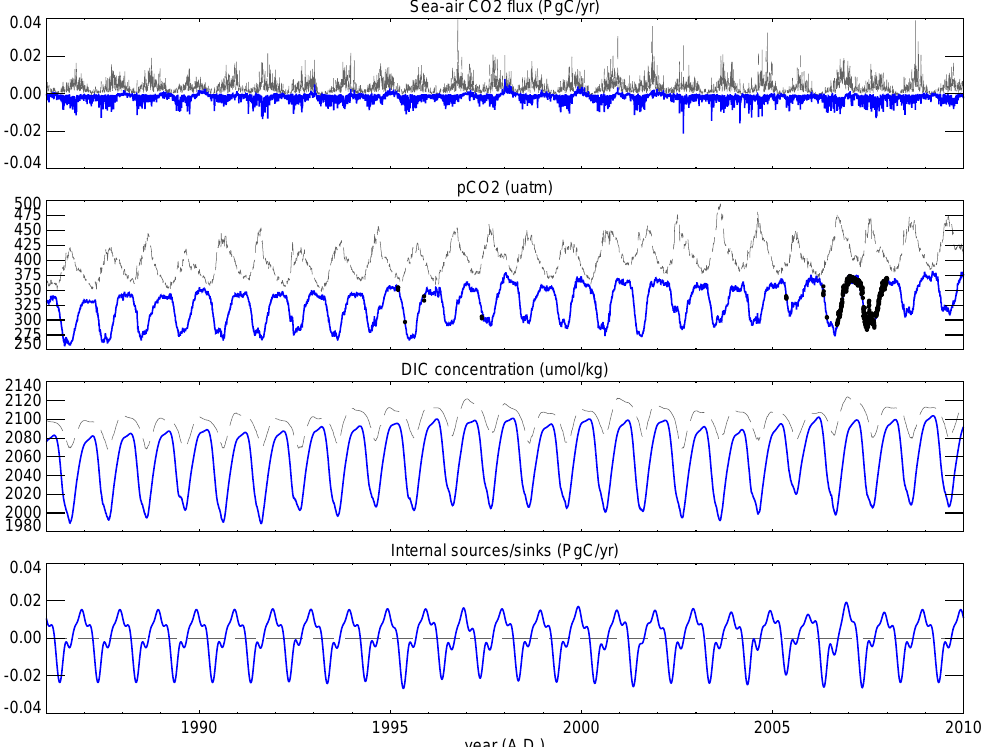
Fig. 3. Example time series (full daily resolution) at the model pixel at around Station M (66 ◦ N, 2 ◦ E) of the main quantities of the diagnostic model (Figure 1): Sea-air CO 2 fluxes ( f CO 2 ma ), surface-ocean CO 2 partial pressure ( p CO 2 m ), mixed-layer DIC concentration ( C DIC m ), as well as ocean-internal carbon addition to (removal from) the mixed layer ( f DIC int ). Estimates have been obtained by fitting the diagnostic scheme to SOCAT surface-ocean CO 2 partial pressure data ( SFC , blue). The SOCAT data points that happen to fall in the example pixel are shown as black dots in the p CO 2 m panel. The Bayesian prior ( f DIC int = 0 and corresponding C DIC m , p CO 2 m , and f CO 2 ma , Appendix A2.2, Sect. 3.2) is also given (thin dashed gray).